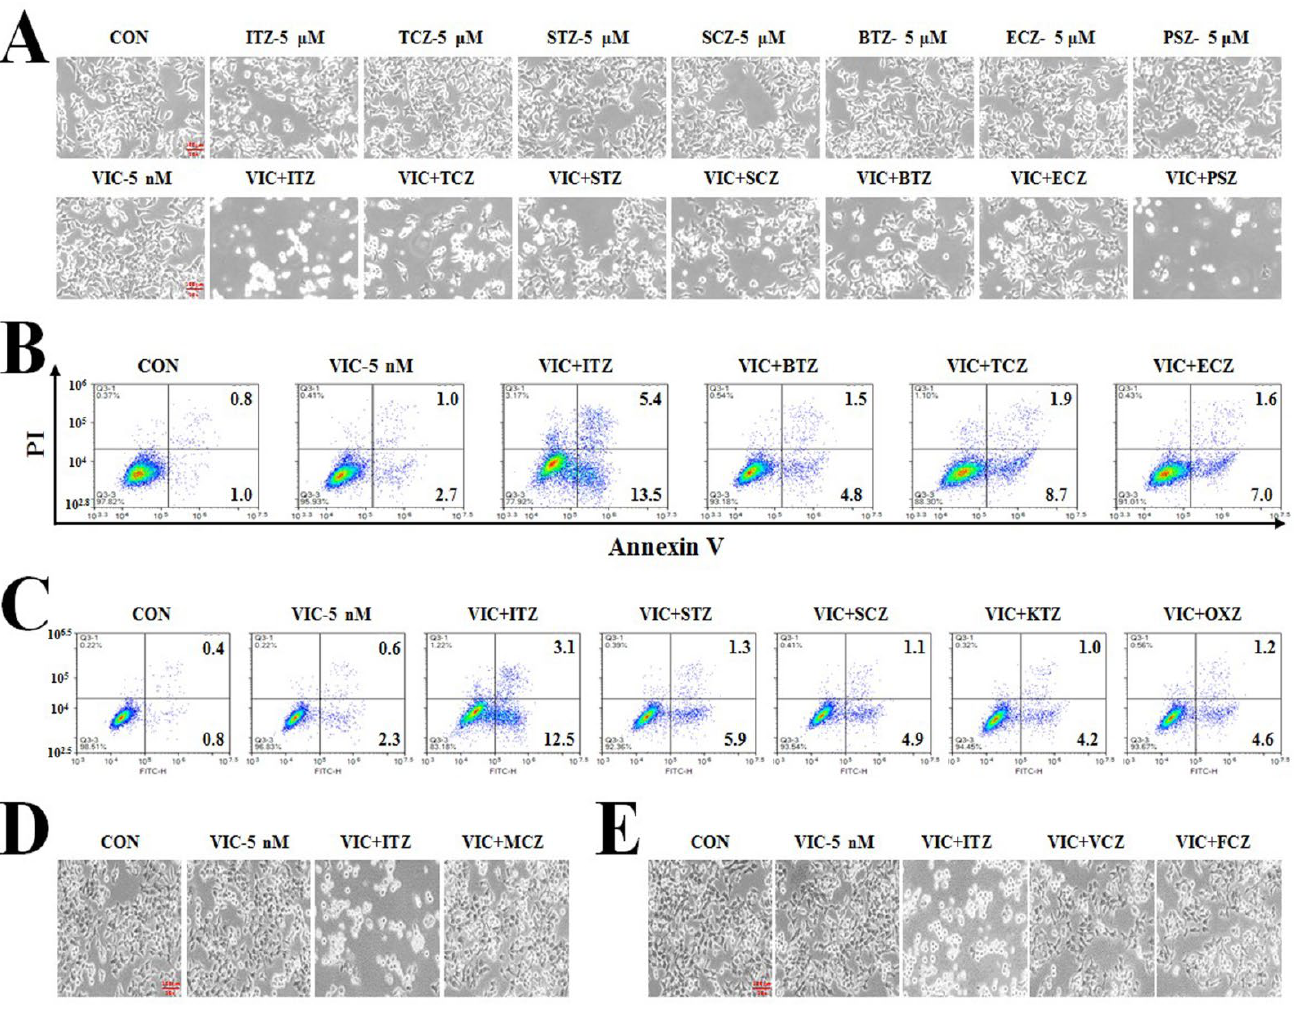
Figure 4. Low treatment with TCZ, itraconazole, and posaconazole exert higher cytotoxic effects in P-gp-overexpressing cancer cells than that of other azole antifungal drugs. ( A ) KBV20C were treated with 5 nM VIC, the indicated μM concentrations of itraconazole (ITZ), TCZ, sertaconazole (STZ), sulconazole (SCZ), BTZ, econazole (ECZ), or posaconazole (PSZ) alone, or in combination with 5 nM VIC, or 0.1% DMSO (CON). After one day, all cells were observed using an inverted microscope at ×100 magnification. ( B , C ) KBV20C were treated with 5 nM VIC, 5 nM VIC with 2.5 μM itraconazole (VIC + ITZ), 5 nM VIC with 2.5 μM BTZ (VIC + BTZ), 5 nM VIC with 2.5 μM econazole (VIC + ECZ), 5 nM VIC with 2.5 μM sertaconazole (VIC + STZ), 5 nM VIC with 2.5 μM sulconazole (VIC + SCZ), 5 nM VIC with 2.5 μM ketoconazole (VIC + KTZ), 5 nM VIC with 2.5 μM oxiconazole (VIC + OXZ), or 0.1% DMSO (CON). After 24 h, annexin V analyses were performed as described in Materials and Methods. ( D , E ) KBV20C were treated with 5 nM VIC, 5 nM VIC with 2.5 μM itraconazole (VIC + ITZ), 5 nM VIC with 2.5 μM miconazole (VIC + MCZ), 5 nM VIC with 2.5 μM voriconazole (VIC + VCZ), 5 nM VIC with 2.5 μM fluconazole (VIC + FCZ), or 0.1% DMSO (CON). After one day, all cells were observed using an inverted microscope at ×100 magnification. 2.8. Co-Treatment with TCZ Increases Cytotoxicity in Other P-gp-Overexpressing-Resistant MCF-7/ADR Cancer Cells